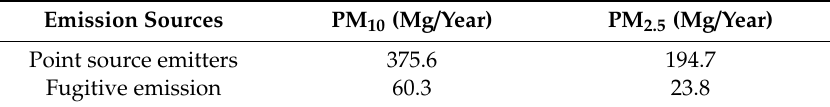
Table 2. PM 10 and PM 2.5 emission from ELT in 2018.